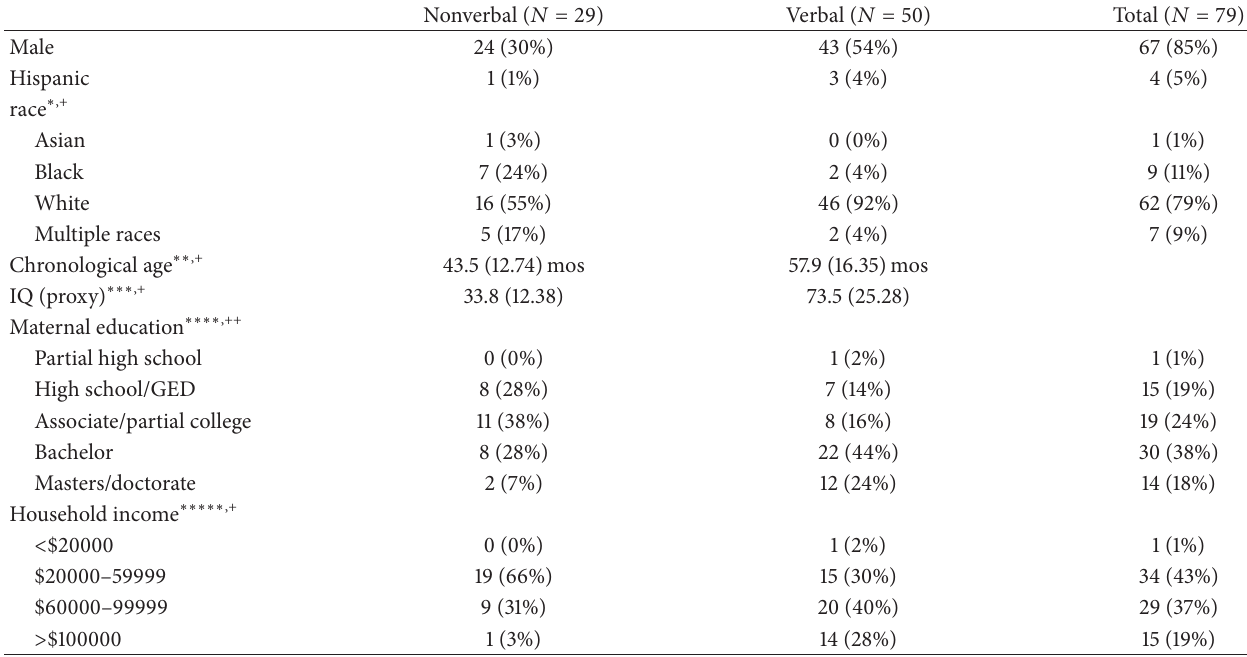
Table 1: Demographic information for cross-sectional